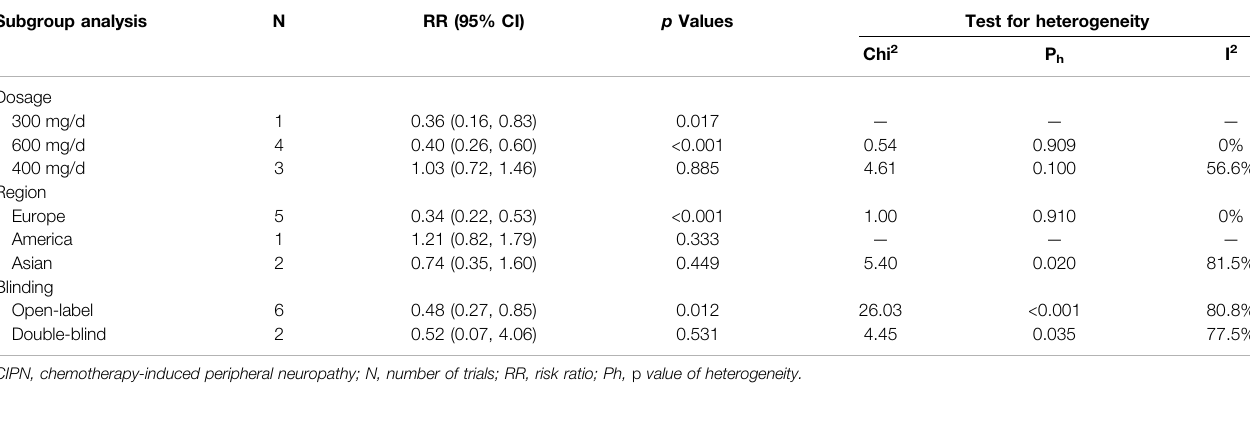
TABLE 3 | Subgroup analysis of the incidence of all-grade CIPN.